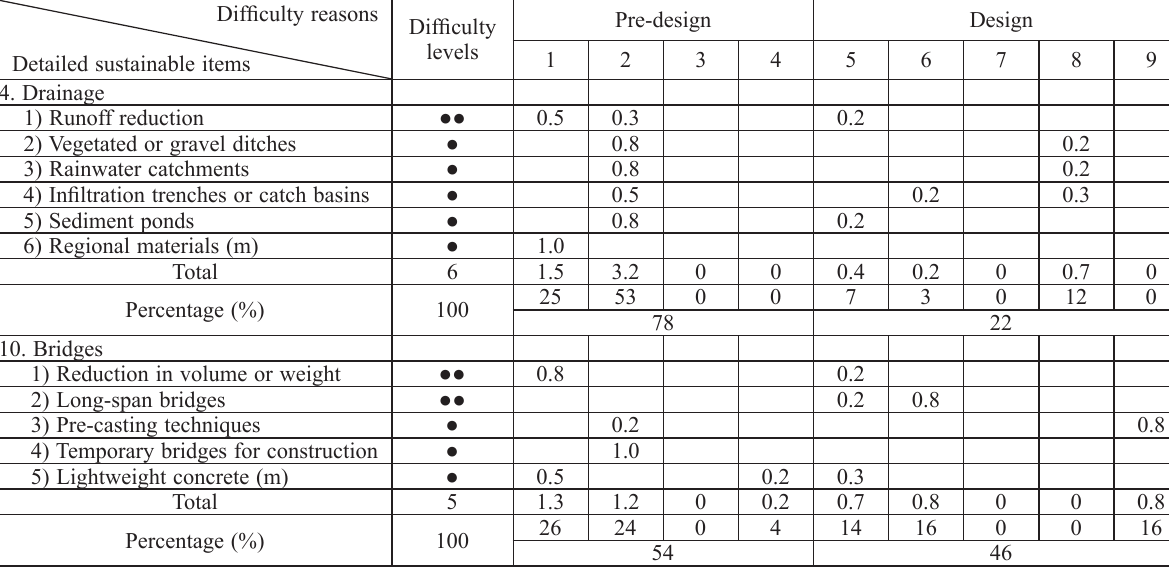
Table 6. Difficulty reasons in detailed drainage and bridge design